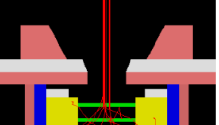
Figure 3. Schematic diagram of telescope system in the high-energy particle detector.